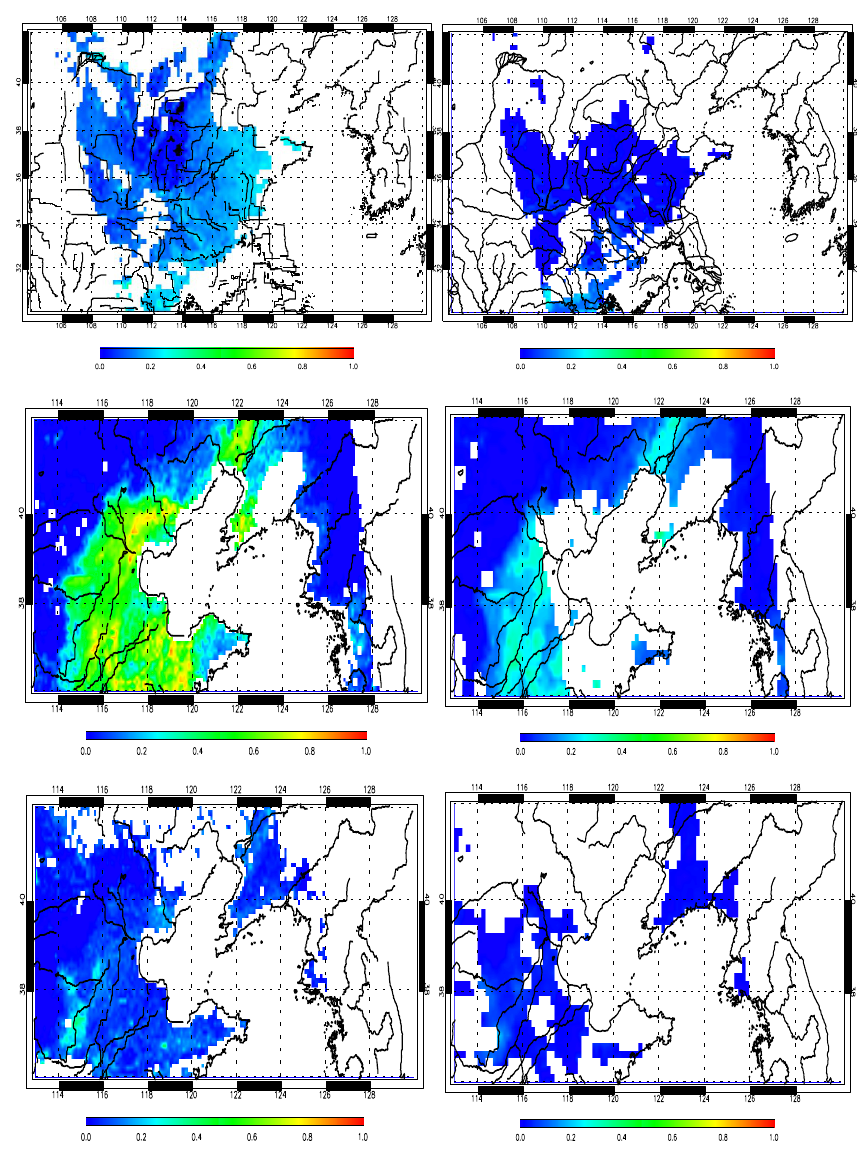
Fig.7. Fine AOD from regional algorithm (Left) and operational algorithm (Right) for an Asian dust Fig. 7. Fine AOD from regional algorithm (left panel) and operational algorithm (right panel) for an Asian dust case (upper panel) on case (Upper) on March 20, 2010, a polluted case (Middle) on October 06, 2010, and a clean 20 March 2010, a polluted case (middle panel) on 6 October 2010, and a clean case (lower panel) on 25 October 2010, case (Lower) on October 25, 2010, respectively.